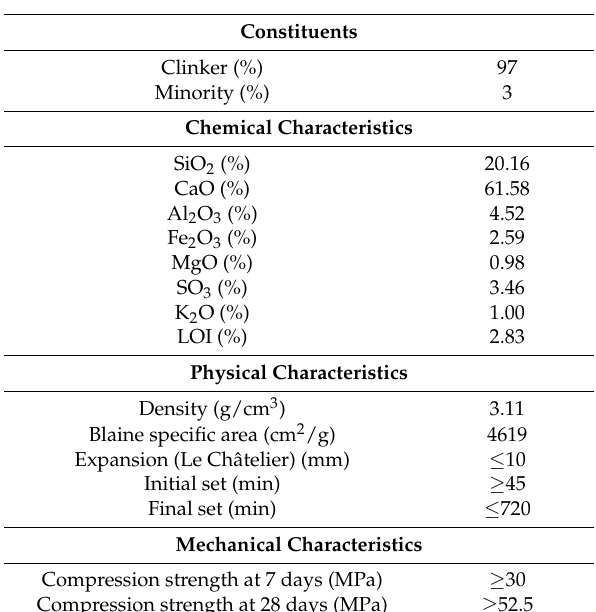
Table 5. Characteristics of CEM